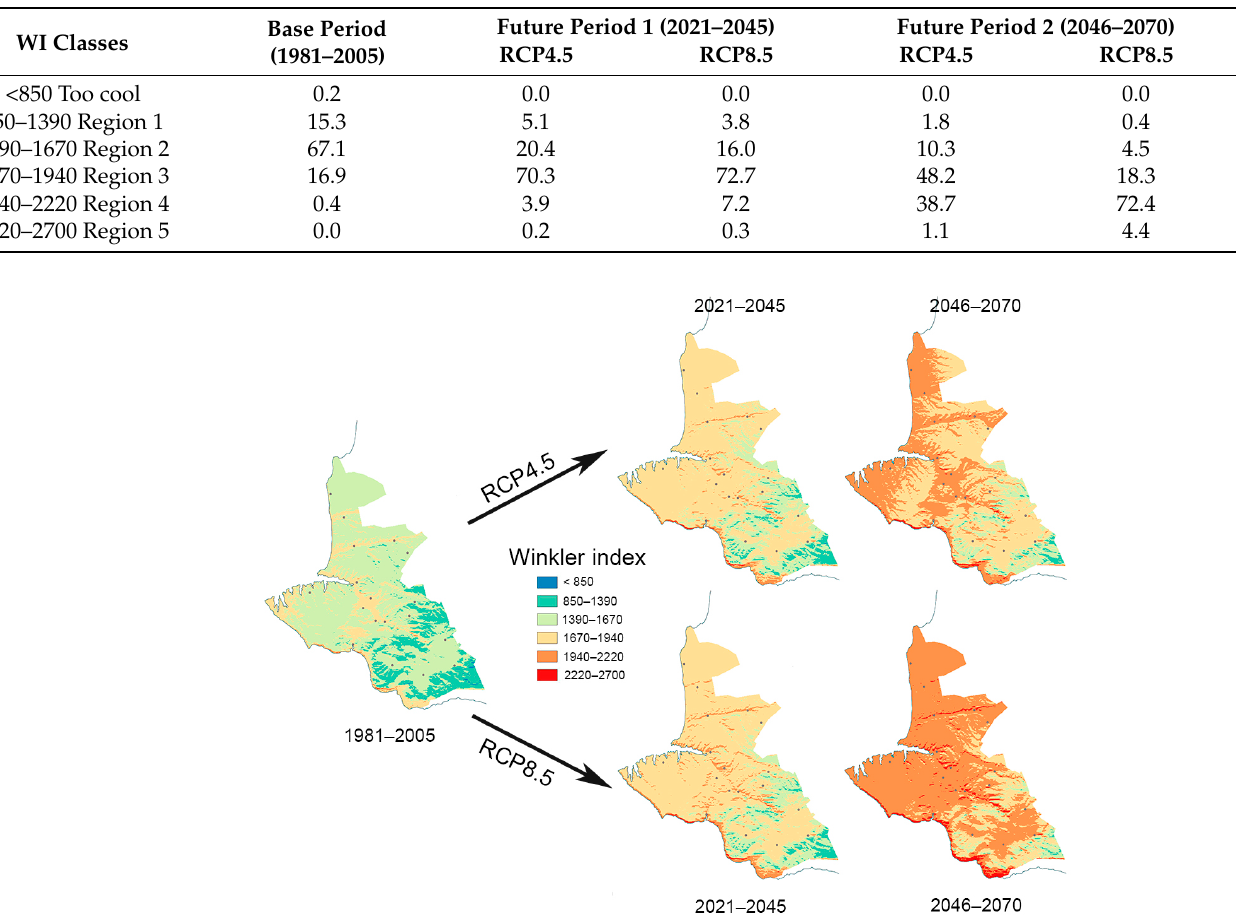
Figure 4. Spatial distribution of the Winkler index over the Sevastopol region obtained by the ensemble of RCMs for the base (1981–2005) and two future periods (2021–2045 and 2046–2070). The dominant class (about 66%) of the Huglin heliothermal index within the base period is the class HI–1 “moderate” with the range of 1800–2100 units (Table 4). About 30% of the regional territory is covered by the class “cool” HI–2. It is associated with elevated areas (southeast part of the region). For the first future period (2021–2045), the territory is redistributed by index classes: the shares of classes “cool” and “temperate” reduce, the class “warm temperate” emerges; under RCP4.5, the latter class is expected to occupy 40% and 48% under RCP8.5 (Figure 5). For the second future period, the percentage belonging to the class HI + 1 (2100–2400 units) will increase up to 65% and 82% under RCP4.5 and RCP8.5, respectively. Therefore, by the forecast values of the Huglin index in the first and second future periods, there are no heliothermal limitations for the ripening of all cultural grape cultivars on the Sevastopol region territory [44].